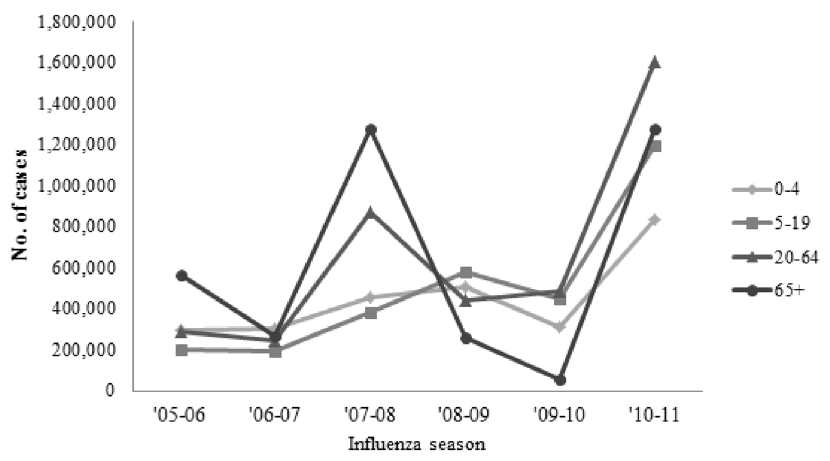
Figure 2. Number of averted influenza cases, by age group, 2005/06–2010/11 influenza seasons.